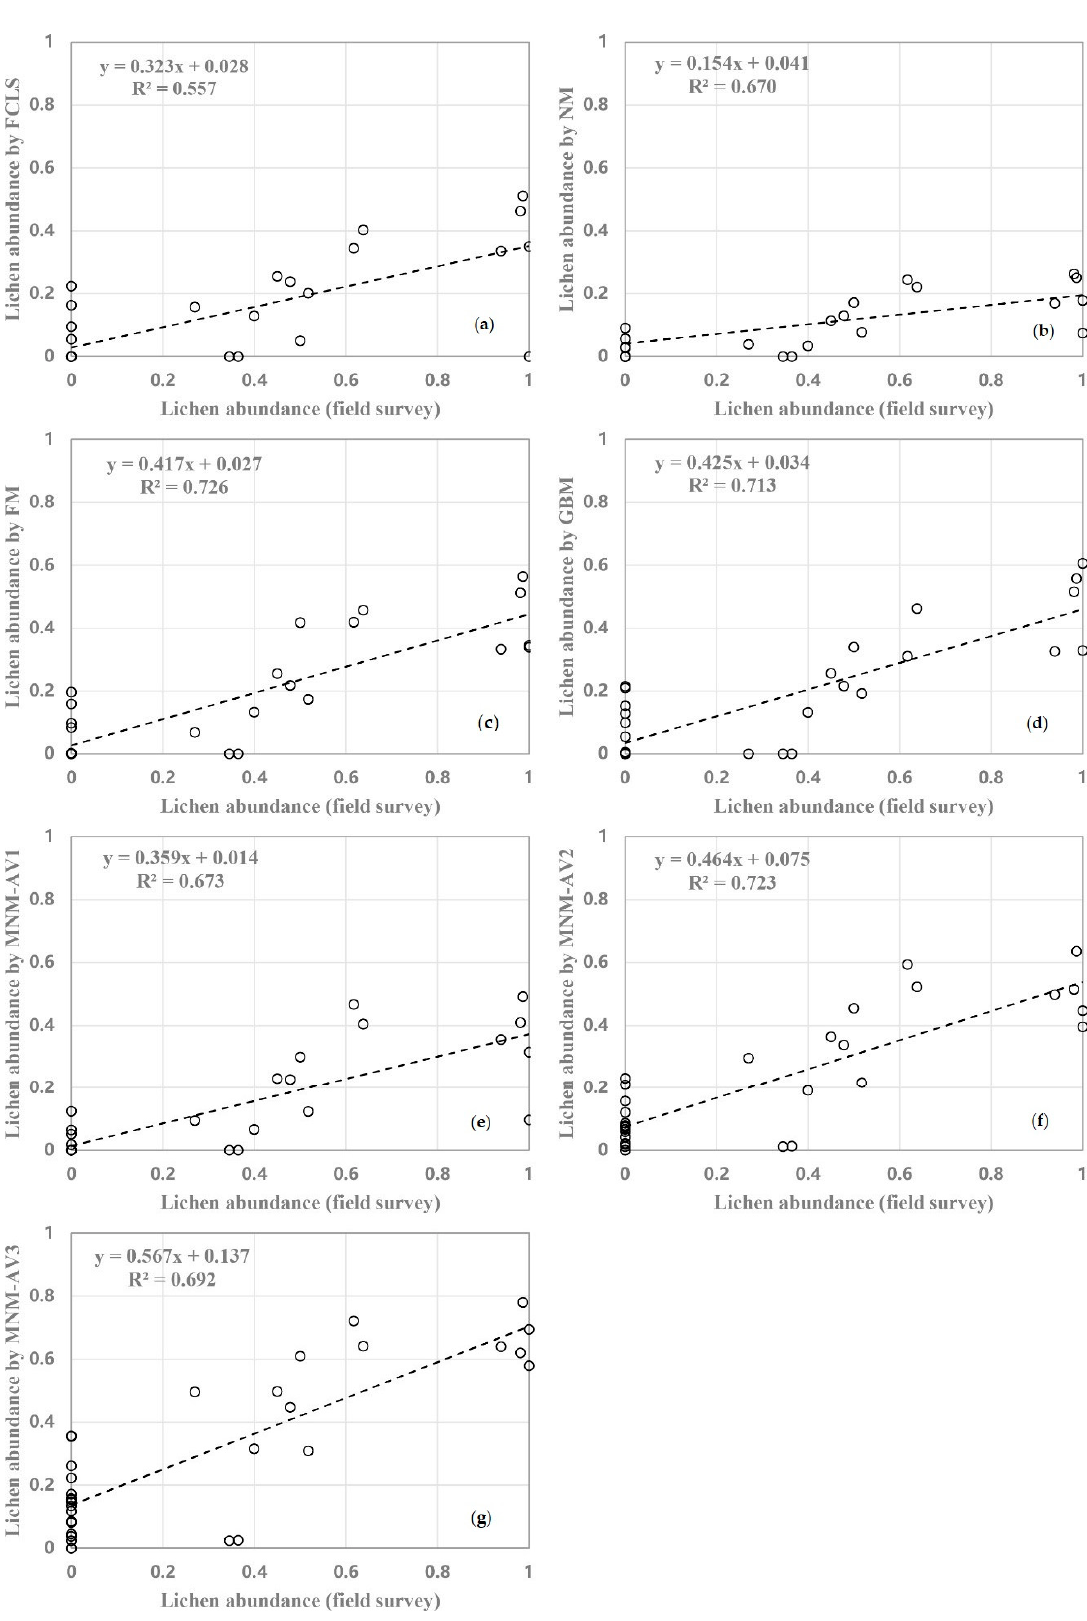
Figure A4. Relationship between lichen abundance derived from field surveys and different models estimates ( a ) FCLS; ( b ) NM; ( c ) FM; ( d ) GBM; ( e ) MNM-AV1; ( f ) MNM-AV2; ( g ) MNM-AV3.